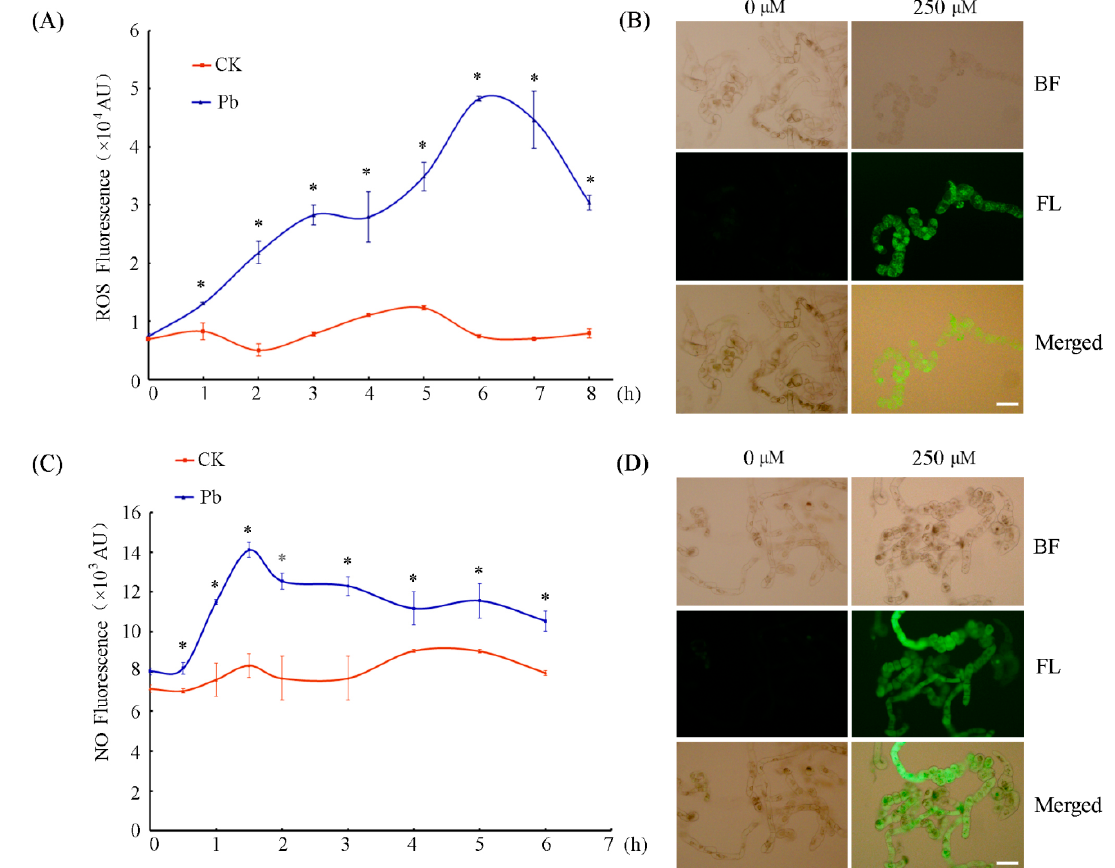
Figure 2. ROS and NO released in tobacco BY-2 cells treated with 250 μ M Pb(NO 3 ) 2 . ( A ) ROS production was measured at different times after treatment with or without 250 μ M Pb(NO 3 ) 2 . ( B ) The distribution of ROS in BY-2 cells detected with 2’,7’-dichlorofluorescin diacetate (DCFH-DA) after 6 h of treatment with 250 μ M Pb(NO 3 ) 2 . Cells that received the same volume of distilled water were used as a control. Scale bar = 100 μ m. ( C ) NO release was measured at different times after treatment with or without 250 μ M Pb(NO 3 ) 2 . ( D ) The distribution of NO in BY-2 cells detected with 3-amino,4-aminomethyl-2’,7’-difluorescein diacetate (DAF-FM DA) after 1.5 h of treatment with 250 μ M Pb(NO 3 ) 2 . Cells that received the same volume of distilled water were used as a control. Scale bar = 100 μ m. Each value in A and C represents the average of three independent experiments and the bars indicate the standard error of the mean. Asterisks indicate values that are significantly different from those of control cells ( p < 0.05). CK, Control; BF, Bright Field; FL, Fluorescence.